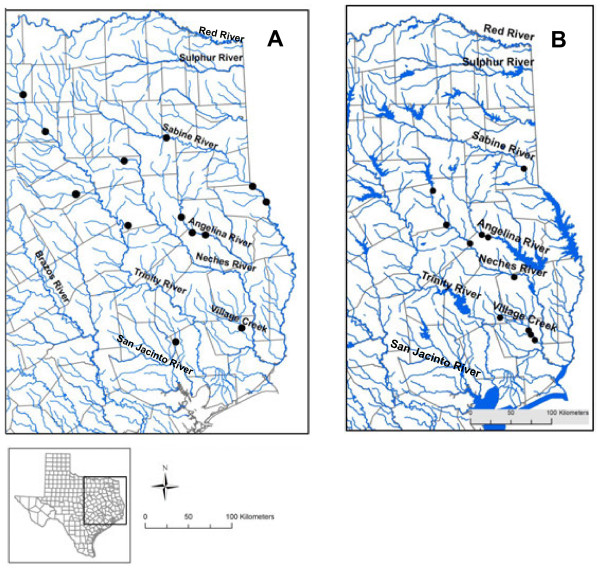
Historical (before 1940, A) and current (1990-present, B) distribution ofPleurobema riddelliiin Texas. Historical data are from Frierson [24], Strecker [34], Bachtel [35]. Current data include authors’ data and literature records [15,30,31].